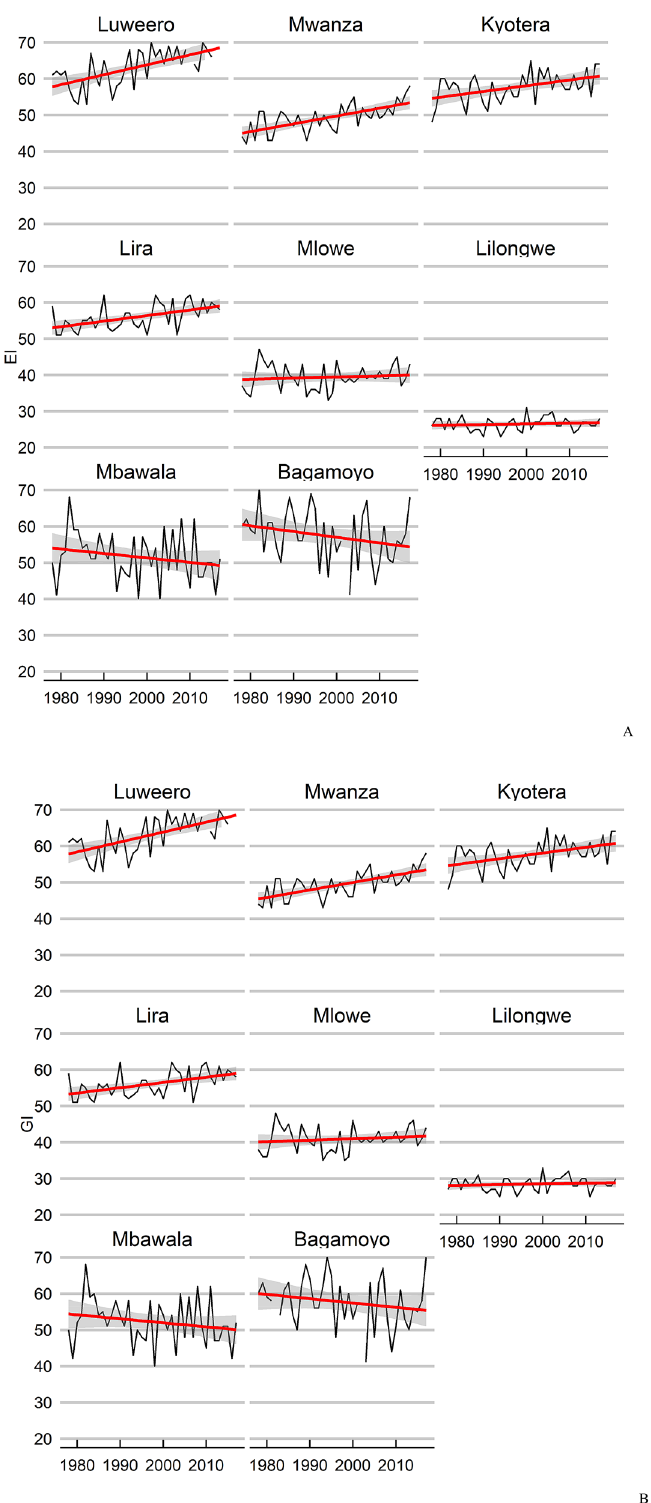
Figure 7. Time-series of annual climate suitability for Bemisia tabaci MEAM1 between 1989 and 2011 for selected locations in East Africa modelled using CLIMEX 53,64 running the CRU time series dataset Mitchell 77 . ( A ) Ecoclimatic Index (EI), ( B ) Annual Growth Index (GI A ), ( C ) Temperature Index (TI) and ( D ) Moisture Index (MI). The locations were selected to span a range of climatic trends spanning the three focal countries for the study (Uganda, Tanzania and Malawi). Locations are identified in Fig.